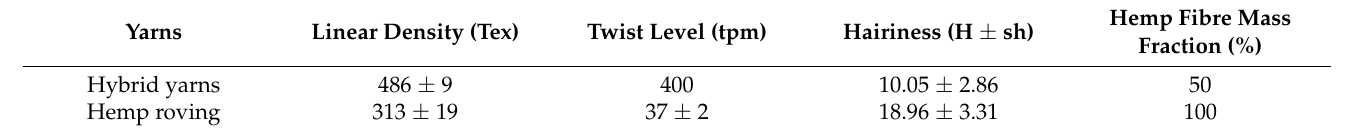
Table 2. The textile properties of the hybrid yarns and hemp roving.